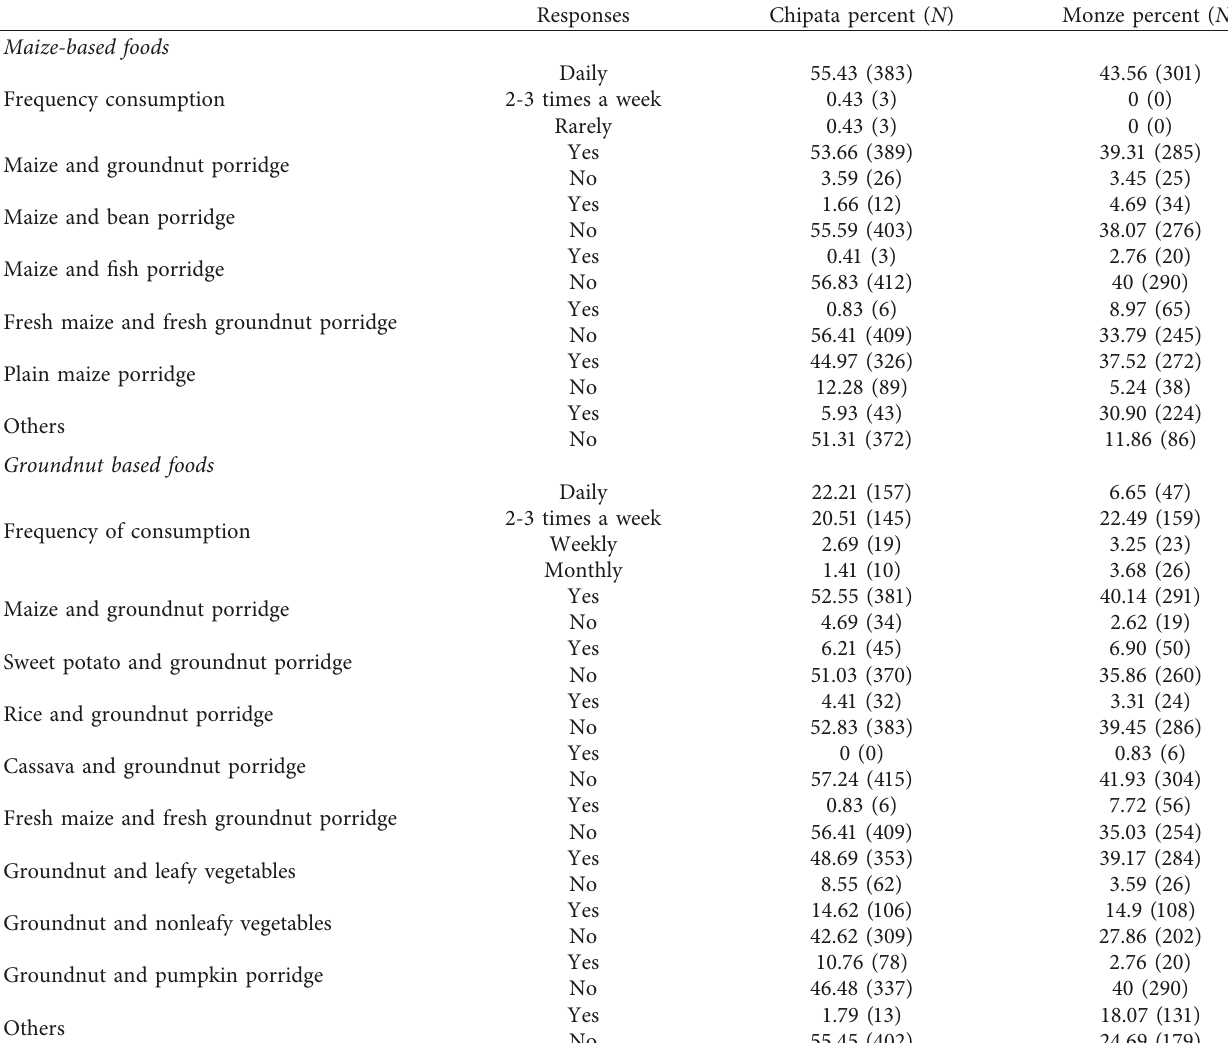
Table 2: Household consumption of maize-based and groundnut based foods in Chipata and Monze